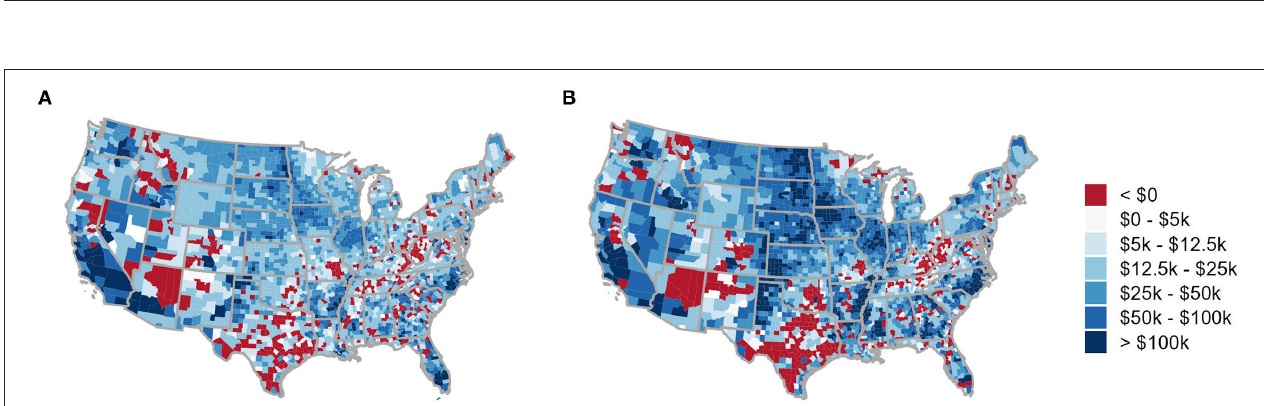
FIGURE 6 | Inflation adjusted net cash farm income of operations (measured in $/operation) reported by the USDA NASS in (A) 2002 and (B) 2017. Data: USDA NASS QuickStats.